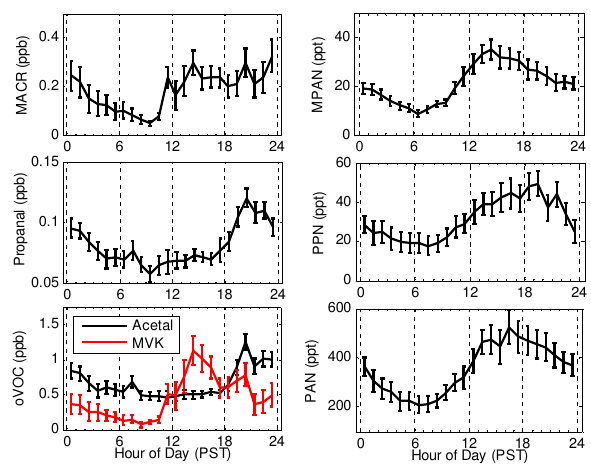
Methyl Glyoxal (MGLY) b 139 NO b OH